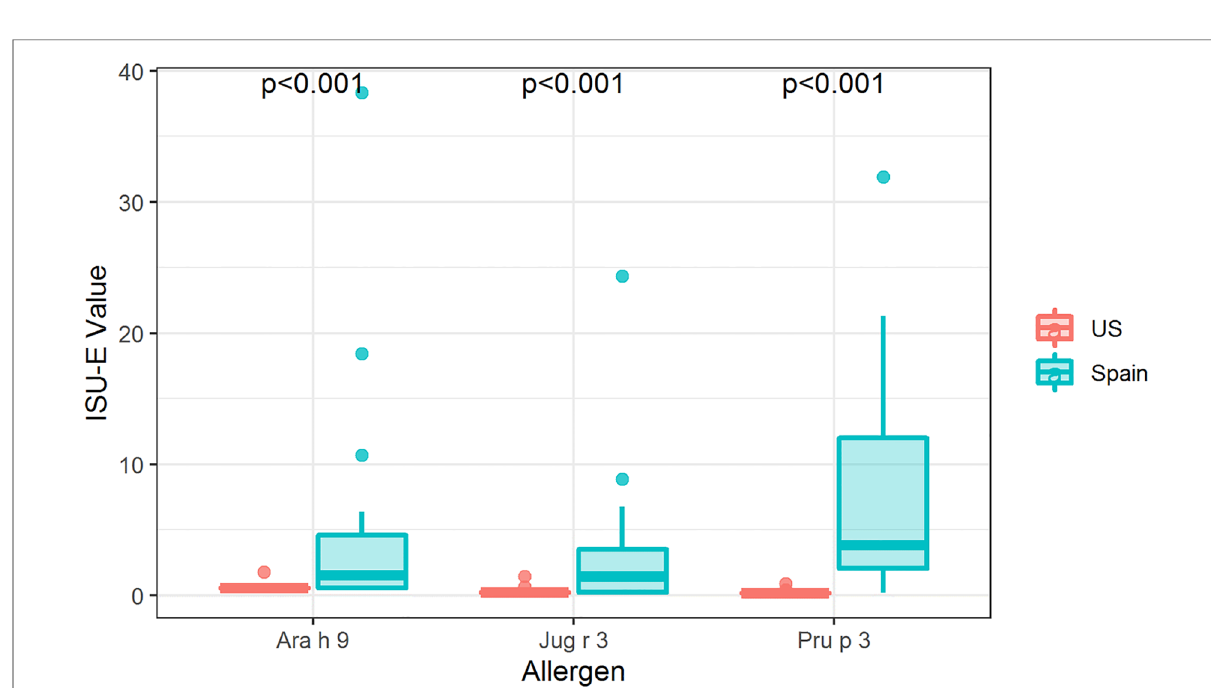
FIGURE 4 IgE binding to intact LTPs by region. Boxplot depicting ISAC array detection of sera IgE binding to intact Ara h 9, Jug r 3, and Pru p 3 in the US and Spain. P -values indicate a signi fi cant difference between regions as determined by Wilcoxon rank-sum tests per allergen. US, N =54; Spain, N